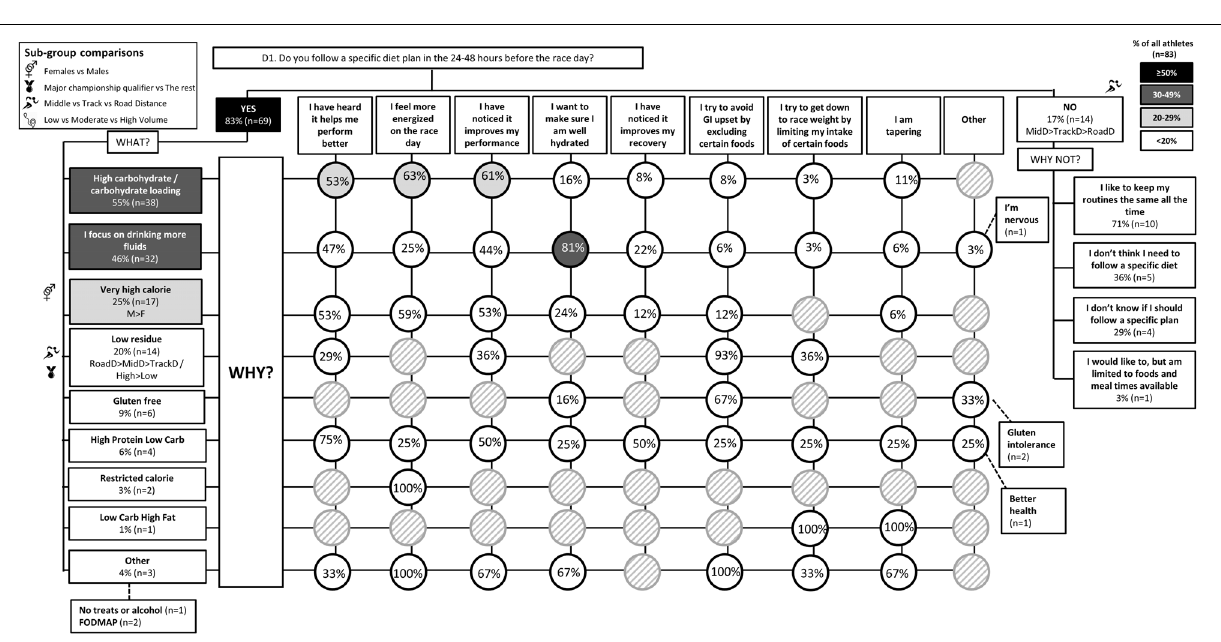
Namely, male athletes were more likely to follow a chronically high CHO diet ( Figure 1 ). In addition, a greater proportion of females (79%) than males (52%) reported eating less on easy days during the base training phase ( Figure 3 ). Males were